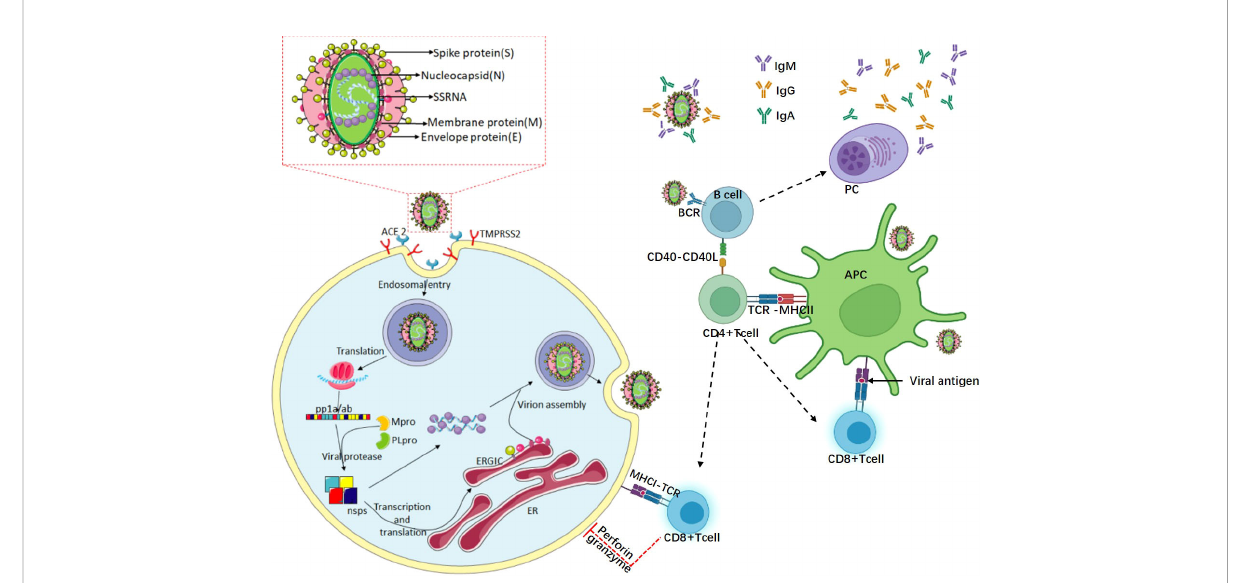
FIGURE 1 The life cycle of SARS-CoV-2 and the speci fi c immune response to the virus. The virus particles of SARS-CoV-2 are composed of four major proteins, envelope (E), spike glycoprotein (S), membrane (M), and the nucleocapsid (N). SARS-CoV-2 promotes virus invasion through the interaction between the S protein, hACE2, and TMPRSS2. After successful invasion, the viral genome RNA is released in the cytoplasm, and then initiates the translation of the genome. The translated polymeric proteins are cleaved by Mpro and PLpro to generate non-structural proteins (nsps). These nsps are involved in viral replication and transcription. With the nucleocapsid (N) protein-encapsidated genomic RNA, the structural proteins are translocated to the endoplasmic reticulum (ER) membrane and assembled into a new virus in the ER-to-Golgi intermediate compartment (ERGIC). Finally, virus particles are secreted from infected cells via exocytosis. APC, B cells, CD4+ T cells, and CD8+ T cells are the main cells that participate in adaptive immunity. The virus is recognized by professional antigen-presenting cells (such as dendritic cells and macrophages), and the viral peptides are presented to CD4+ T cells through the major histocompatibility complex (MHCII) class II. Then, the CD4+ T cells differentiate into a series of helper cells, which in turn help activate CD8+ T cells and B cells. CD8+ T cells can kill infected cells with the assistance of CD4+ T cells and MHCI. Simultaneously, B cells transform into plasma cells to produce neutralizing antibodies to prevent the virus from invading